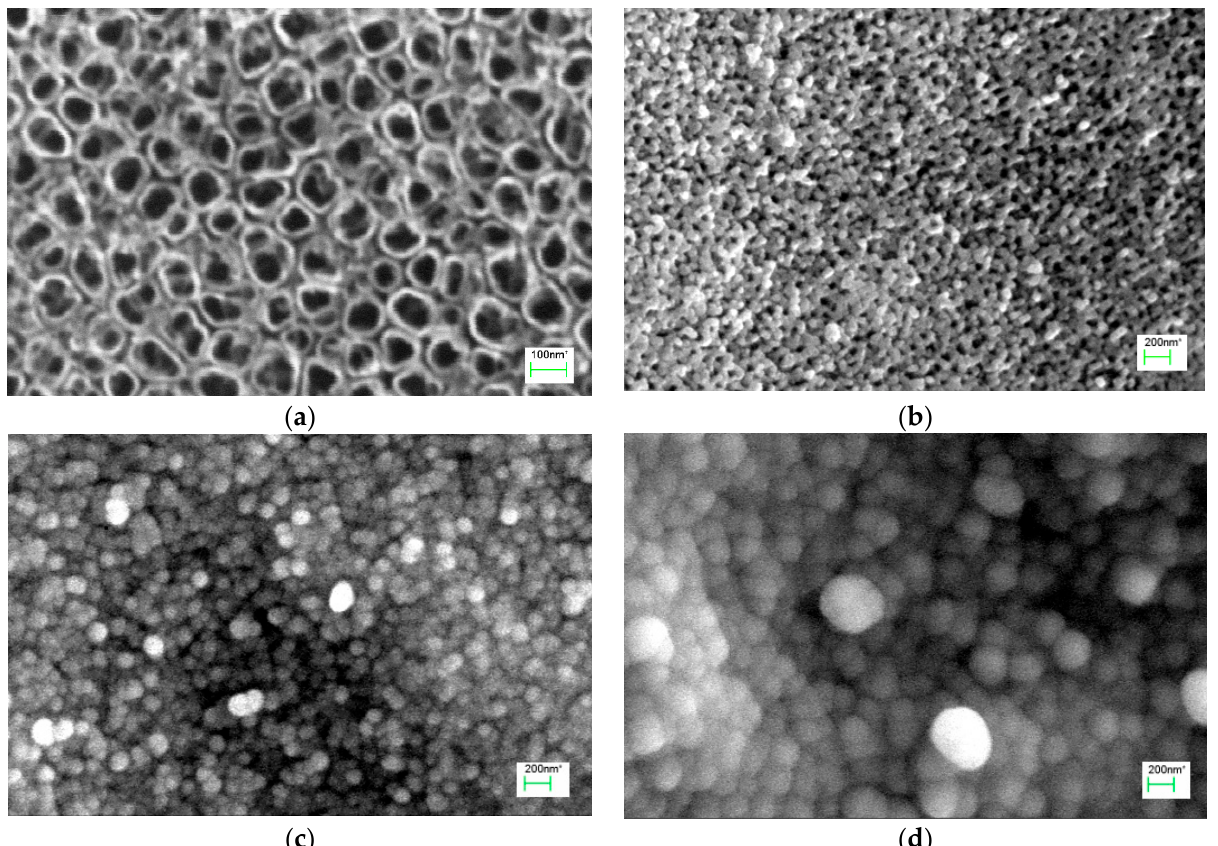
Figure 1. The surface morphology of: ( a ) TiO 2 ntb, ( b – d ) Ni-TiO 2 ntbs fabricated by the dipping of the TiO 2 ntb in the Ni plating solution operated at 85 ◦ C for ( b ) 5, ( c ) 20, and ( d ) 60